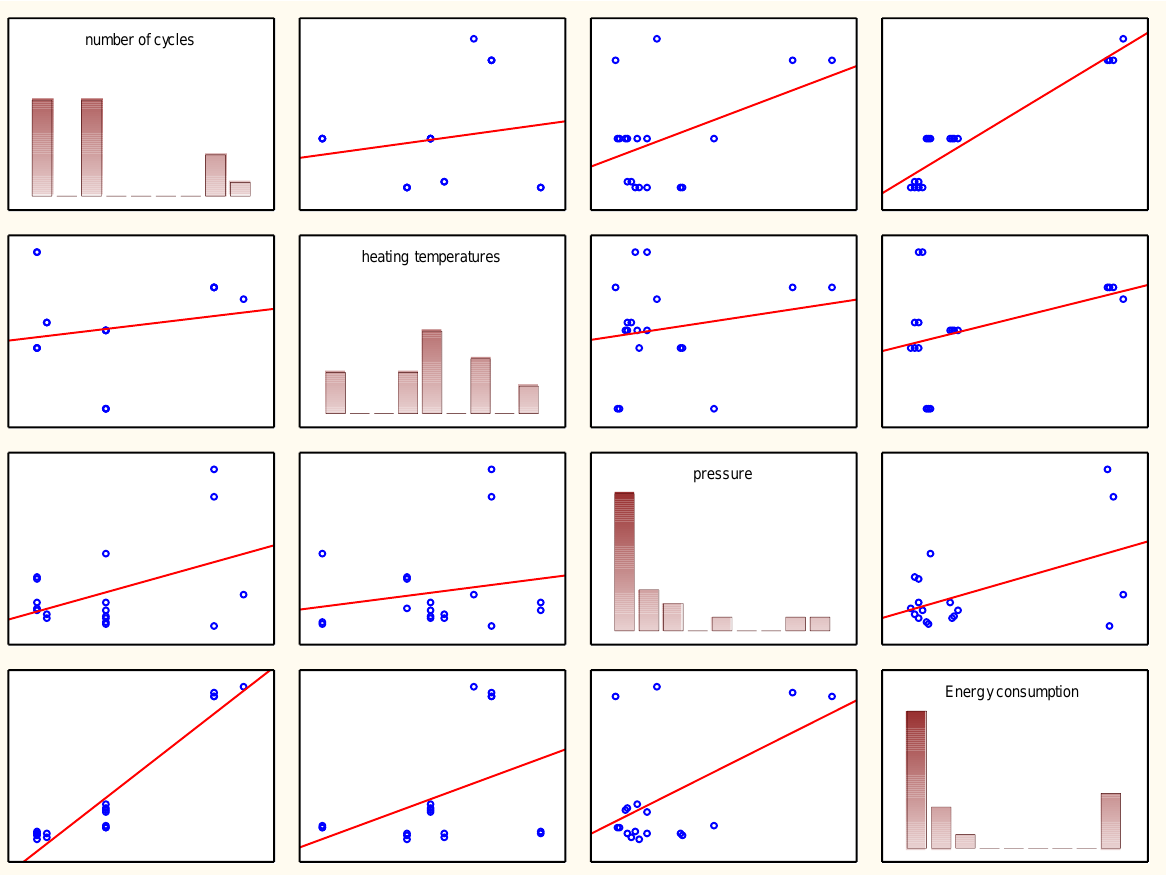
Figure 4. The prediction model for the energy consumption—matrix correlation plot. The prediction model for the energy consumption was verified on the real data of the low-pressure carburising processes (Table